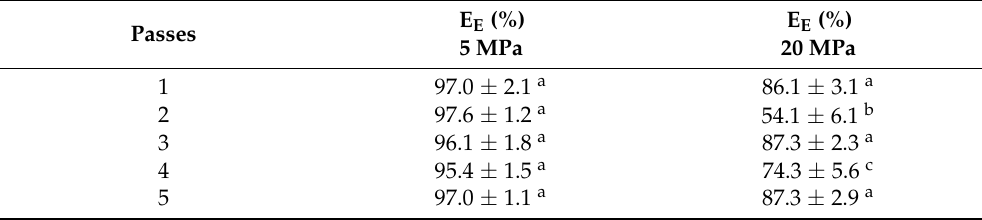
Table 3. Encapsulation efficiency (E E ) for the emulsions as a function of the number of emulsion passes through the high-pressure homogenizer (steps) and the two pressures studied (5 MPa and 20 MPa). Different superscript letters within a column indicate significant differences ( p < 0.05). E E (%) Passes 5